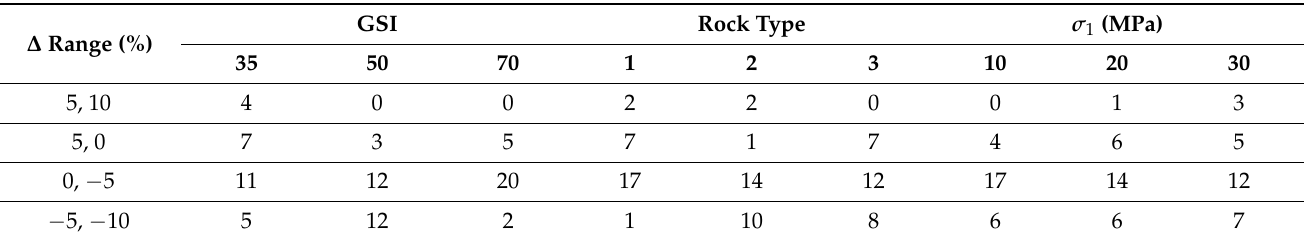
Table 7. Number of cases for the various error ranges for maximal differential stress in the